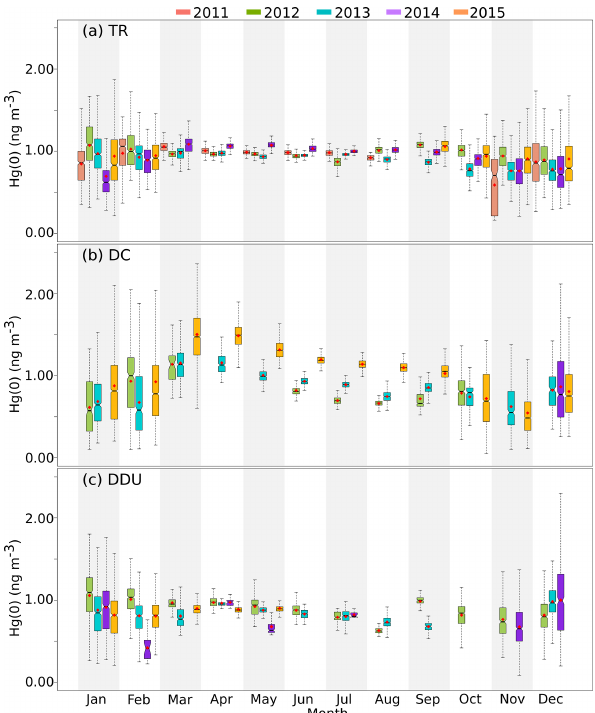
Figure 9. Box and whisker plots presenting the monthly Hg(0) con- centration distribution at ground-based Antarctic sites (a) TR, (b) DC, and (c) DDU in 2011 (pink), 2012 (green), 2013 (turquoise), 2014 (purple), and 2015 (orange). Red diamond: mean. Bottom and top of the box: first and third quartiles. Band inside the box: me- dian. Ends of the whiskers: lowest (highest) datum still within the 1.5 interquartile range of the lowest (upper) quartile. Outliers are not